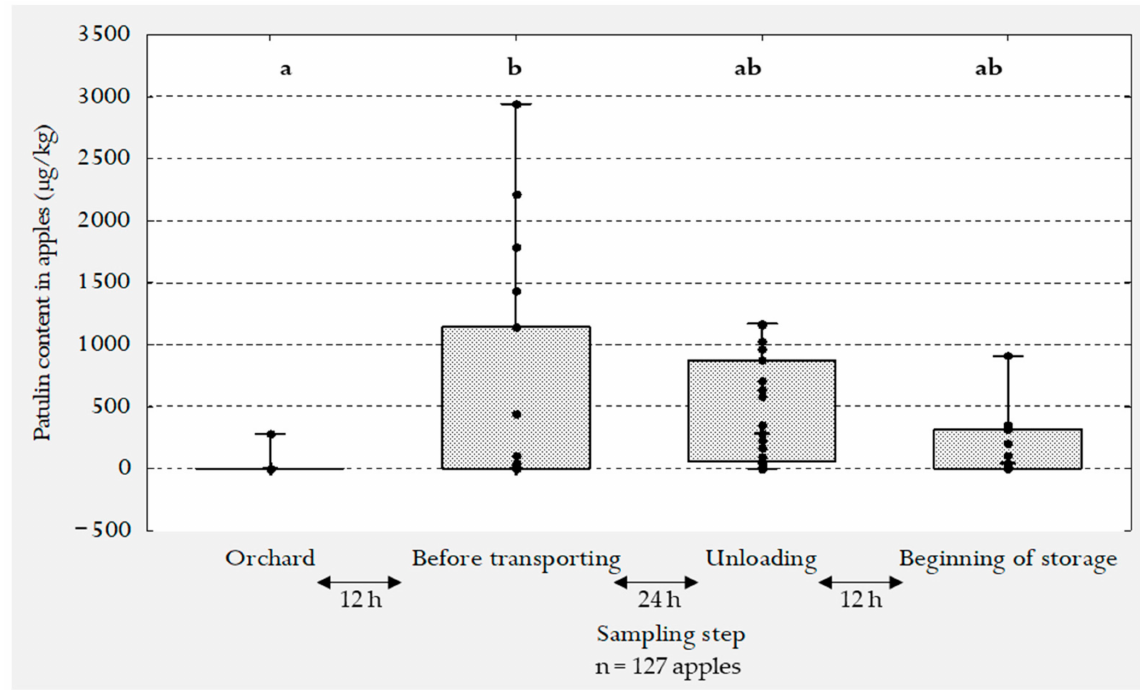
Figure 3. The distribution of patulin ( µ g/kg) at different post-harvest steps in total of 127 sampled cider-apples. The upper and lower ends of the whiskers represent respectively the minimum and the maximum values of patulin analyzed at each step. The black dots illustrate the distribution of patulin among all samples showing a wide distribution in the step before transporting that is narrowed at the last two